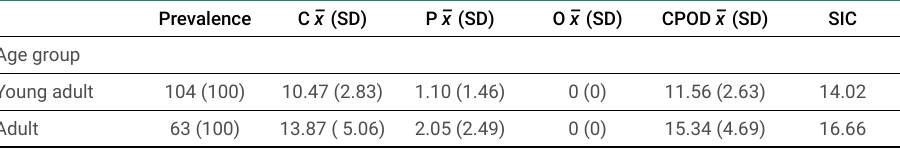
Table 3. Prevalence, experience and significance of dental caries of the inhabitants of native communities, according to age group.